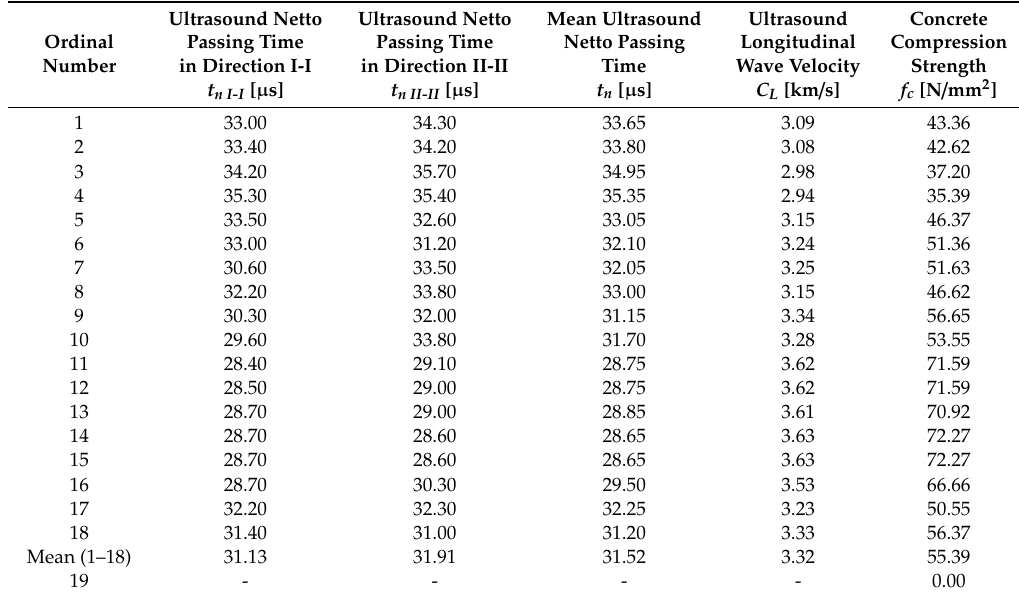
Table 3. Results of concrete compression strength test in borehole No. 1.